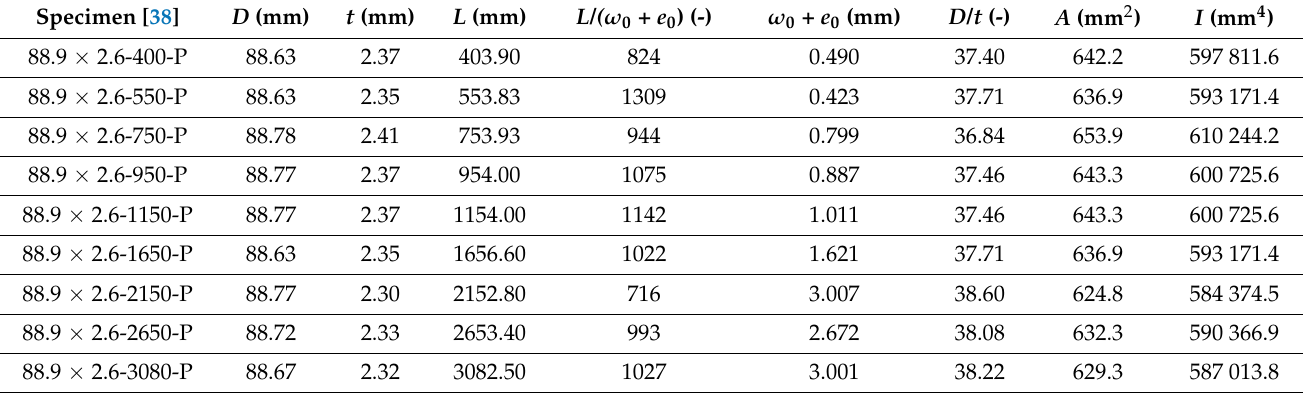
Table 5. Measured and calculated geometric properties of the cross-section set 88.9 × 2.6 CHS pin-ended columns (duplex